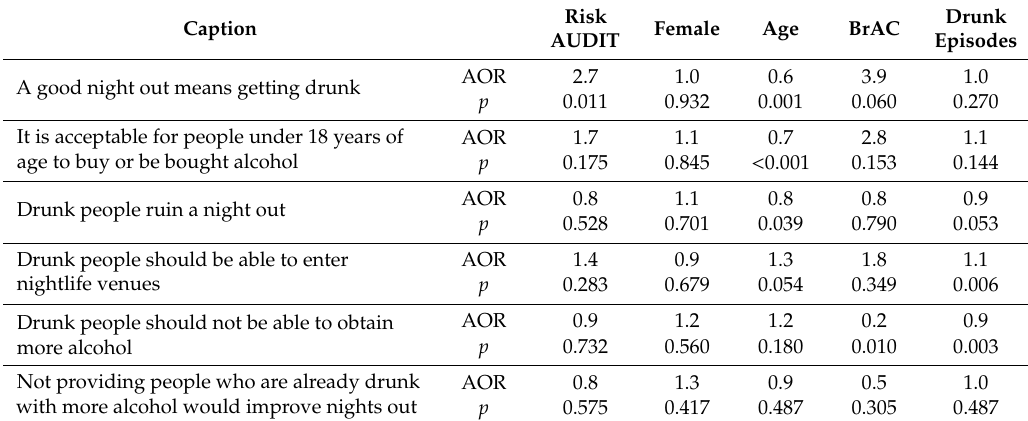
Table 3. Adjusted analyses (odds ratios) of the relationship between attitudes, demographics and alcohol use, controlling by the amount of time spent in the public